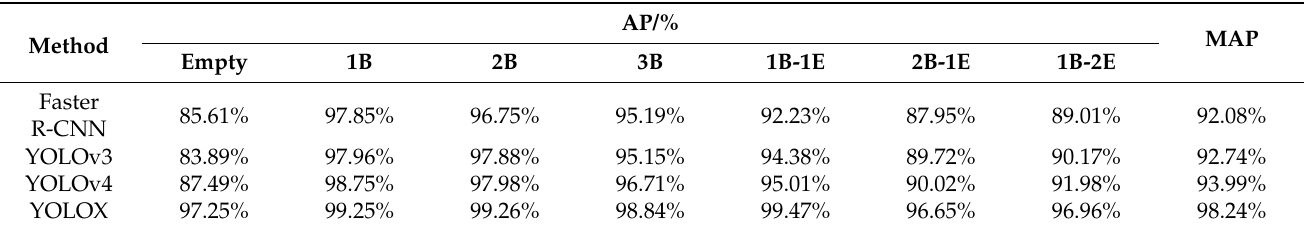
Table 6. Average accuracy versus average accuracy of pod category detection for different models in the test dataset CPD.